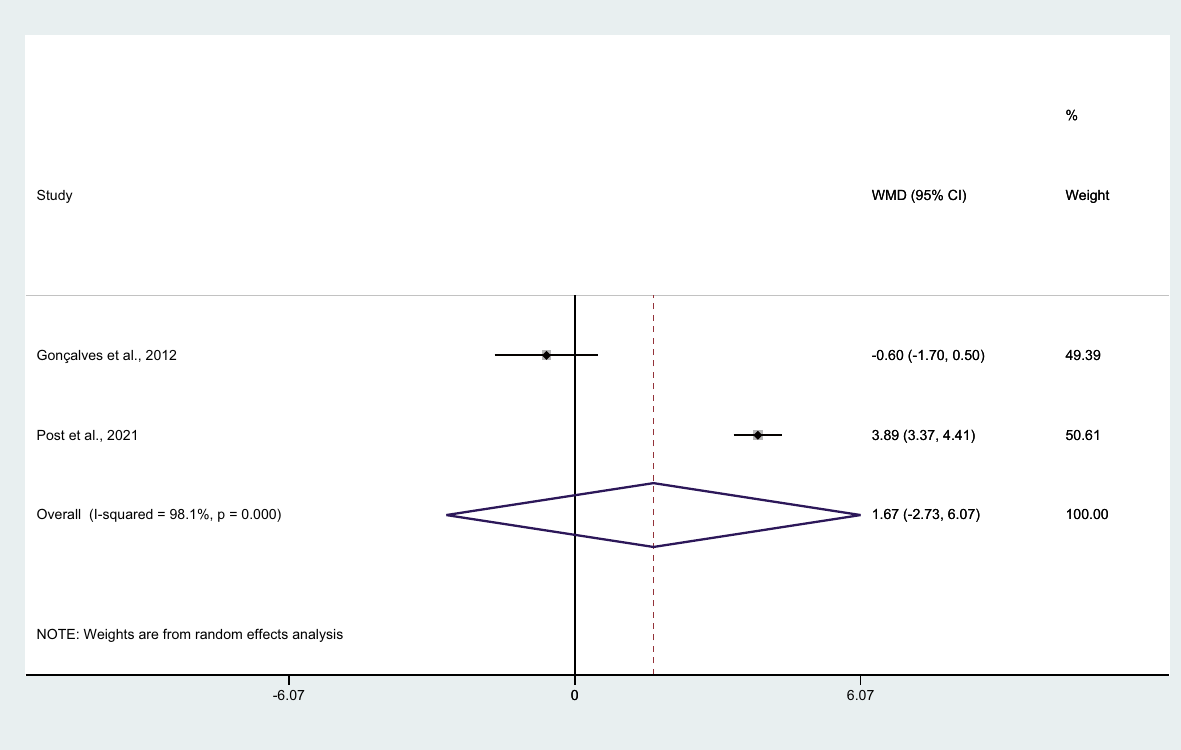
Figure 14. Differences in IL-6 levels between patients with asymptomatic malaria and controls. Abbreviation: WMD, weighted mean difference; CI, confidence interval; black diamond symbol, point estimate; solid line in the middle of the graph at 0, zero effect size; Dashed red line: pooled WMD between the two groups; I 2 , level of heterogeneity; P = 0.000 or less than 0.05, significant